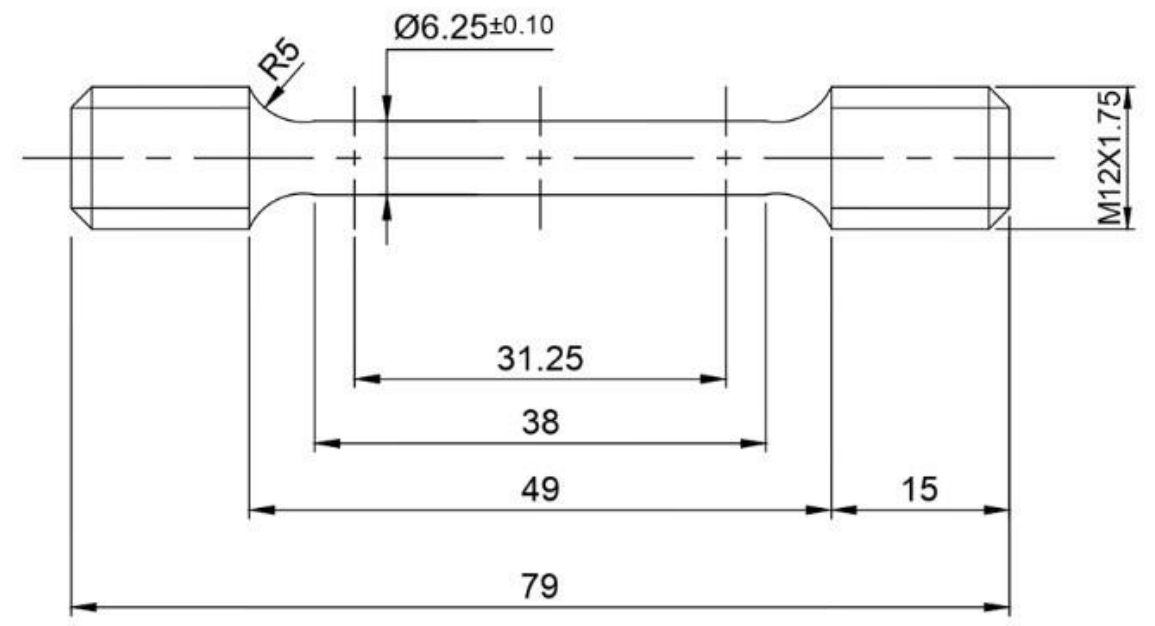
Figure 2. Tensile sample prepared as per ASTM standards.